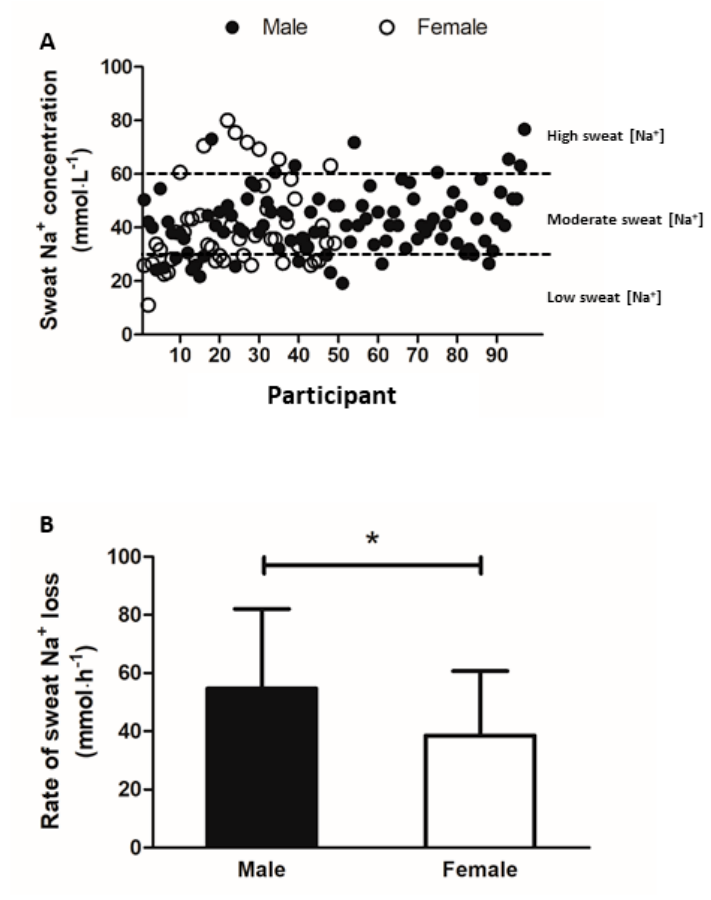
Figure 2. ( A ) Distribution of whole-body sweat Na + concentration (mmol · L − 1 ) among 97 male and 49 female participants; ( B ) rate of sweat Na + loss (mmol·h − 1 ) compared between male and female runners. Data are presented as mean ± SD. * p < 0.05, compared to male participants.